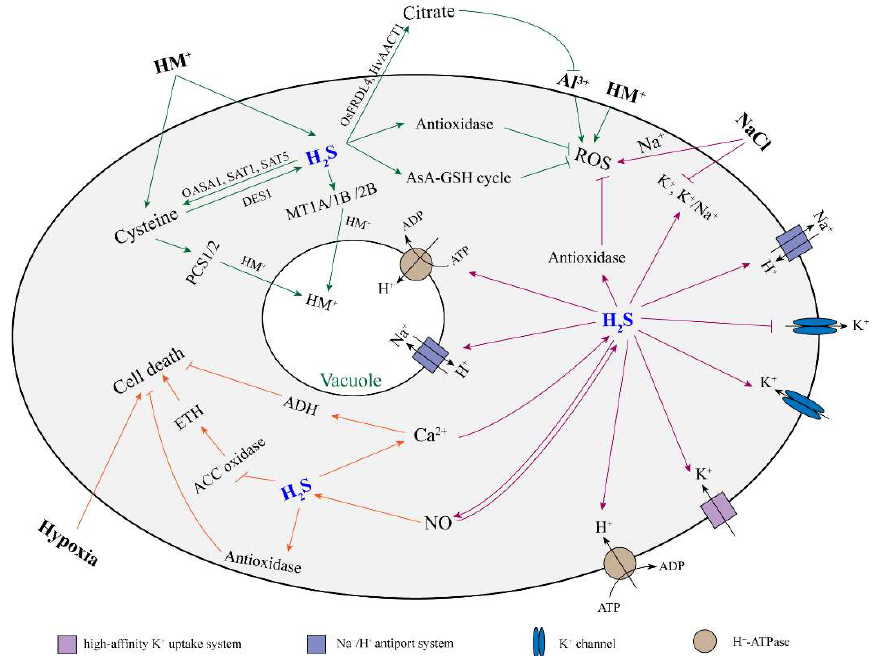
Figure 2. The proposed model of H 2 S alleviating plant root cell damage under abiotic stress. Arrow and bar ends indicate activation and inhibitory effects, respectively. The green, orange, and purple arrows refer to the response of H 2 S in plant roots to heavy metals, hypoxia, and salt stress, respec-